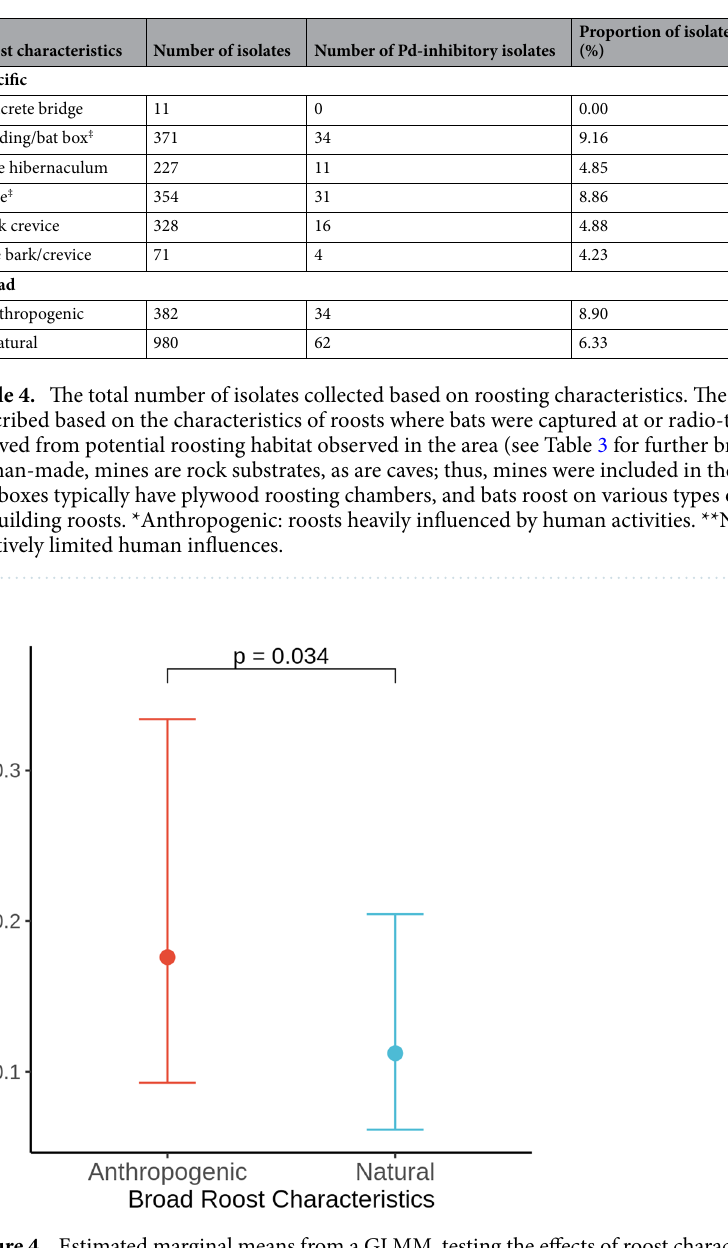
Figure 4. Estimated marginal means from a GLMM, testing the effects of roost characteristics, broad ( A ) and specific groups ( B ), on the prevalence of anti-Pd